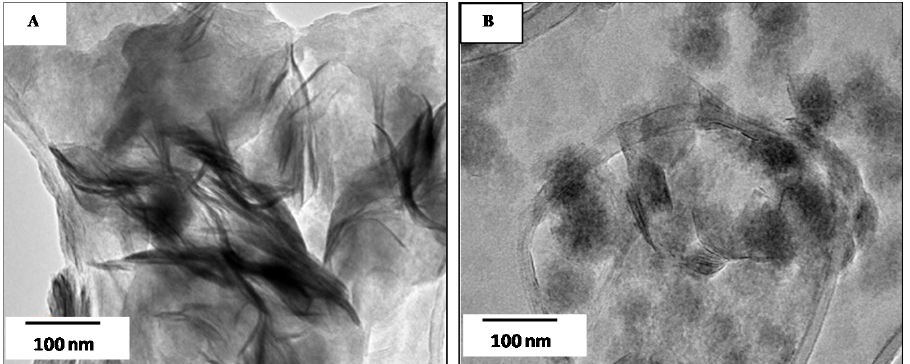
Figure 7. ( A , B ) TEM images of WS 2 nanoflowers.